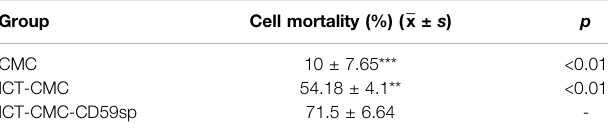
TABLE 2 | Comparison of trypan blue staining results in living cells.